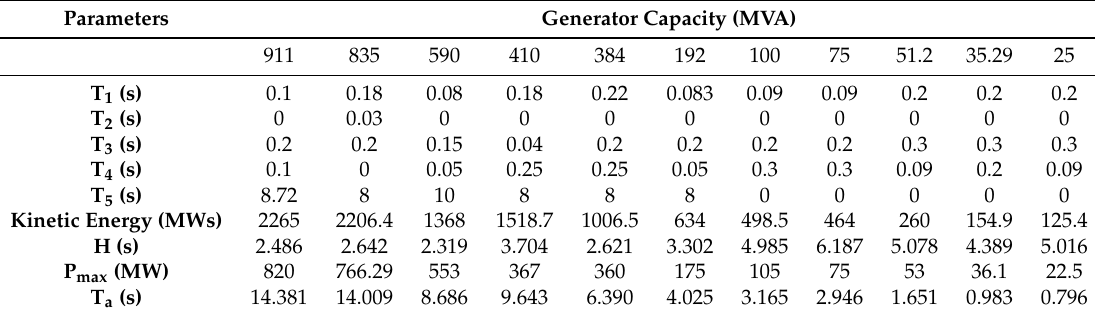
Figure 4. Model of the general-purpose governor for the representation of synchronous machines in the simplified IEEE 9 bus case. Table 4. Typical generator values and governor settings as function of capacity